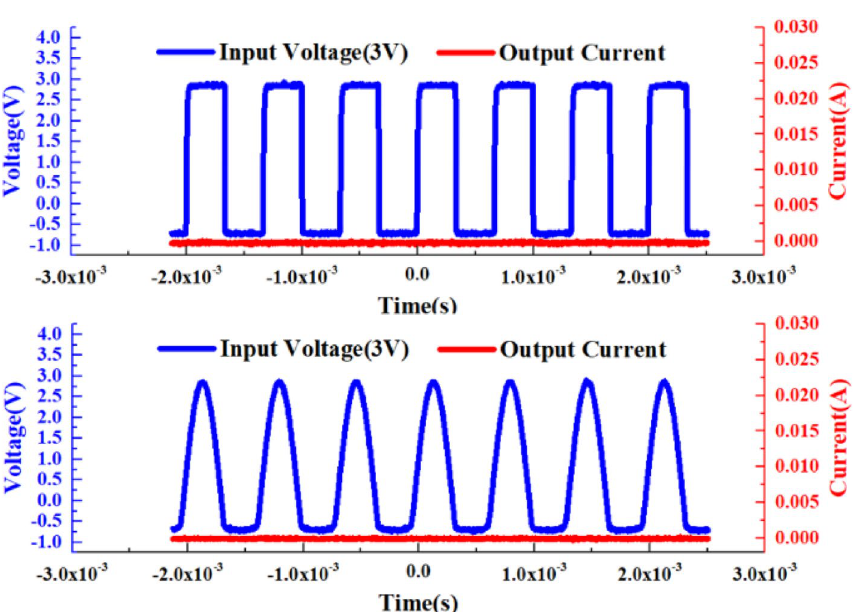
Figure 7. Test voltage–time curve and test current–time curve of VADTS under the excitation of square wave signal and pulse signal (3